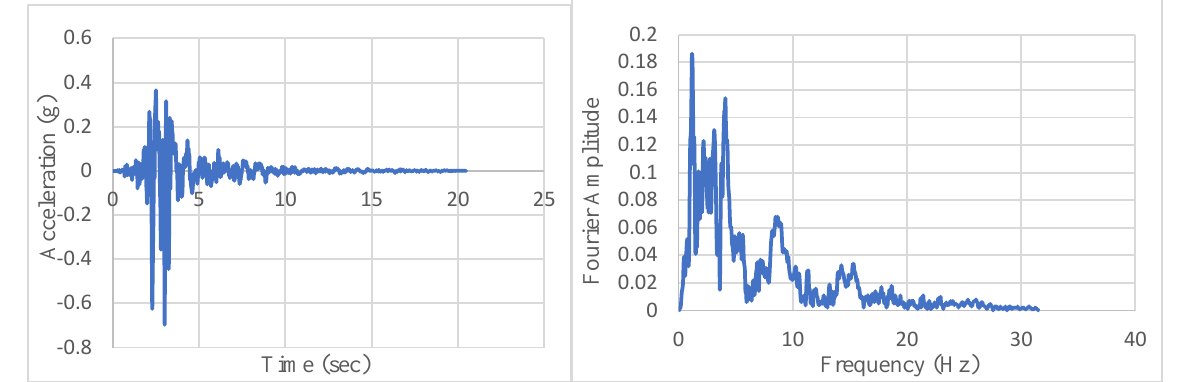
Figure 16. Selected ground motion record and Fourier spectra: Kobe (Japan) earthquake.